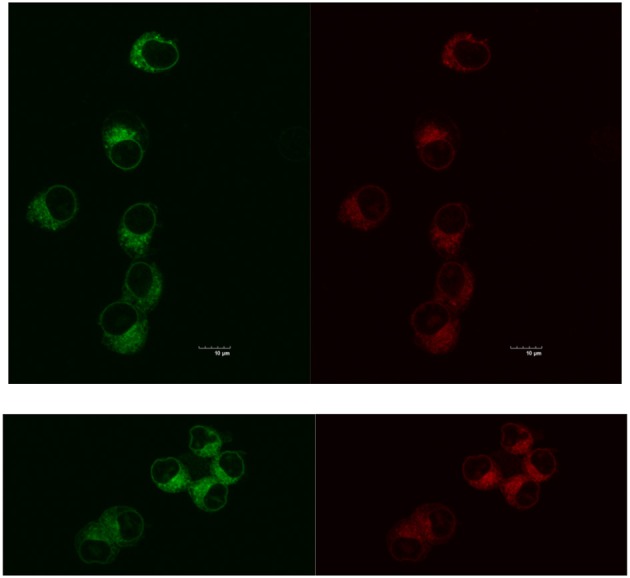
Top, left to right: α-Me4phen-7 accumulation in BHK cells at 25 μM after a 1-h incubation, stained by Mitotracker Green and α-Me4phen-7 (red). Bottom, left to right: Q[10]-encapsulated α-Me4phen-7 accumulation in BHK cells at 25 μM after a 1-h incubation, stained by Mitotracker Green and α-Me4phen-7 (red). Scale bar = 10 μm.